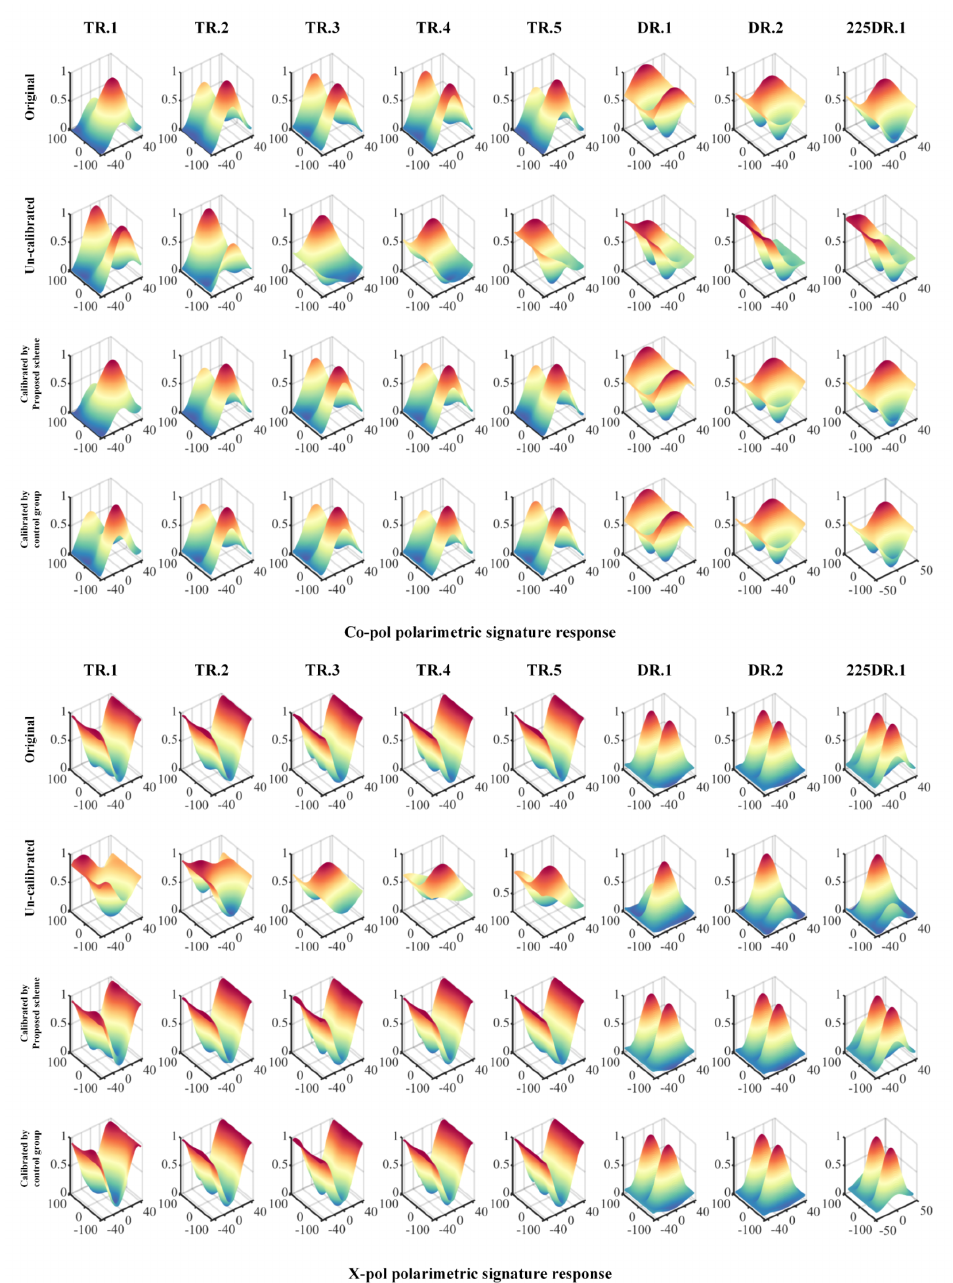
Figure 9. Polarimetric (co-pol and x-pol) signature responses of the strong point targets in the CQP SAR data set, with additive noise on linear polarimetric